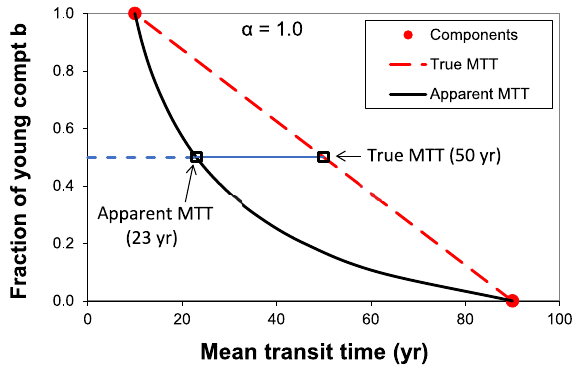
Figure 4. Effect of changing b (the young component fraction) on the aggregation error with the GM with α = 1 for mixing of two components with MTTs of 10 and 90 years. The blue line shows the effects at b = 0 .